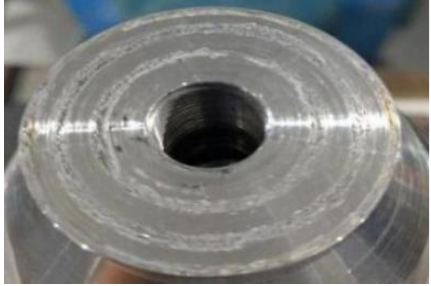
Figure 7. Face of ultrasonic horn without lubrication.